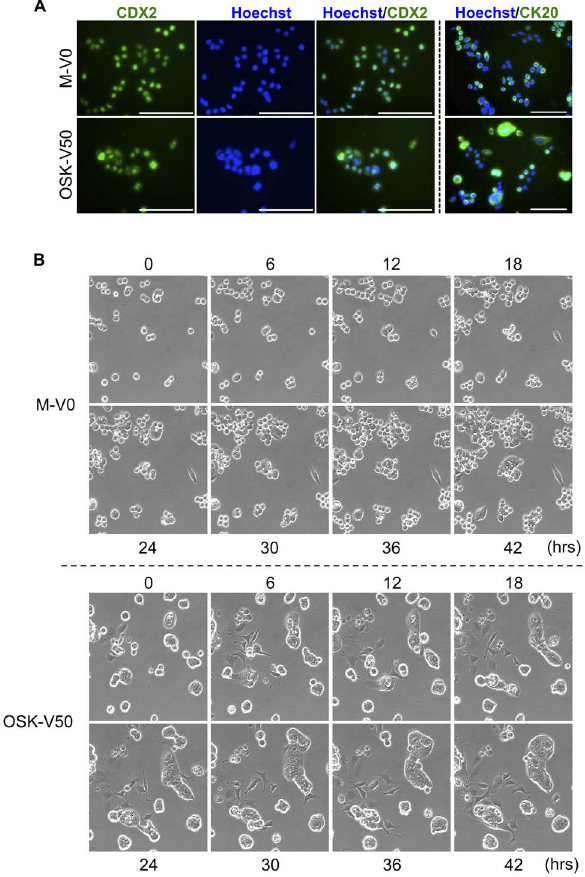
Figure 5. Colonic lineage specificity and potency to produce phenotypical diversity in OSK-V50 cells. (A) Immunocytochemis- try for CDX2 and CK20 protein. OSK-V50 cells were positive for CDX2 and CK20, as well as M-V0 cells. The cells were counterstained with Hoechst33342. Scale bars: 100 m m. (B) The phenotypical diversity in morphology and mobility of derivatives of OSK-V50 cells. Photographs are time-lapse images of M-V0 and OSK-V50 cells. The sorted cells were subsequently cultured for five days and then observed every six hours for 42 hr. Time-lapse imaging revealed that there was a higher diversity in both the morphology and mobility in OSK-V50 cells (lower panel) compared to M-V0 cells (upper panel). Original magnification, 6 20. Movies of M-V0 and OSK-V50 cells are shown in Video S1 and Video S2, respectively.